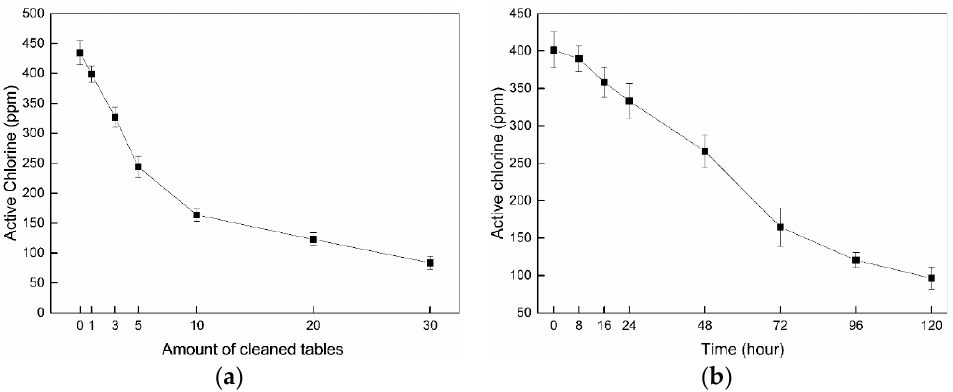
Figure 5. Losses of active chlorine during consecutive cleaning and storage. ( a ) Loss of active chlorine by wiping tables; ( b ) Loss of active chlorine during storage. Symbol: Mean ±